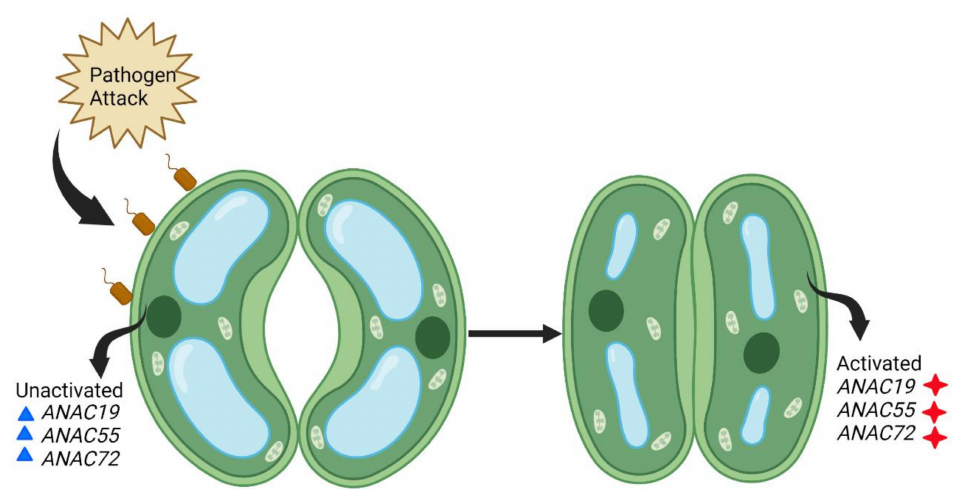
Figure 5. Stomatal innate immunity conferred by three Arabidopsis NACs against biotic stress. Pathogen (brown) attack induces activation of the ANAC19 , ANAC55 , and ANAC72 genes (inactivated genes are in blue and activated in red) and signal pathways in Arabidopsis and, as a consequence, the stomata confer innate immunity by closing the guard